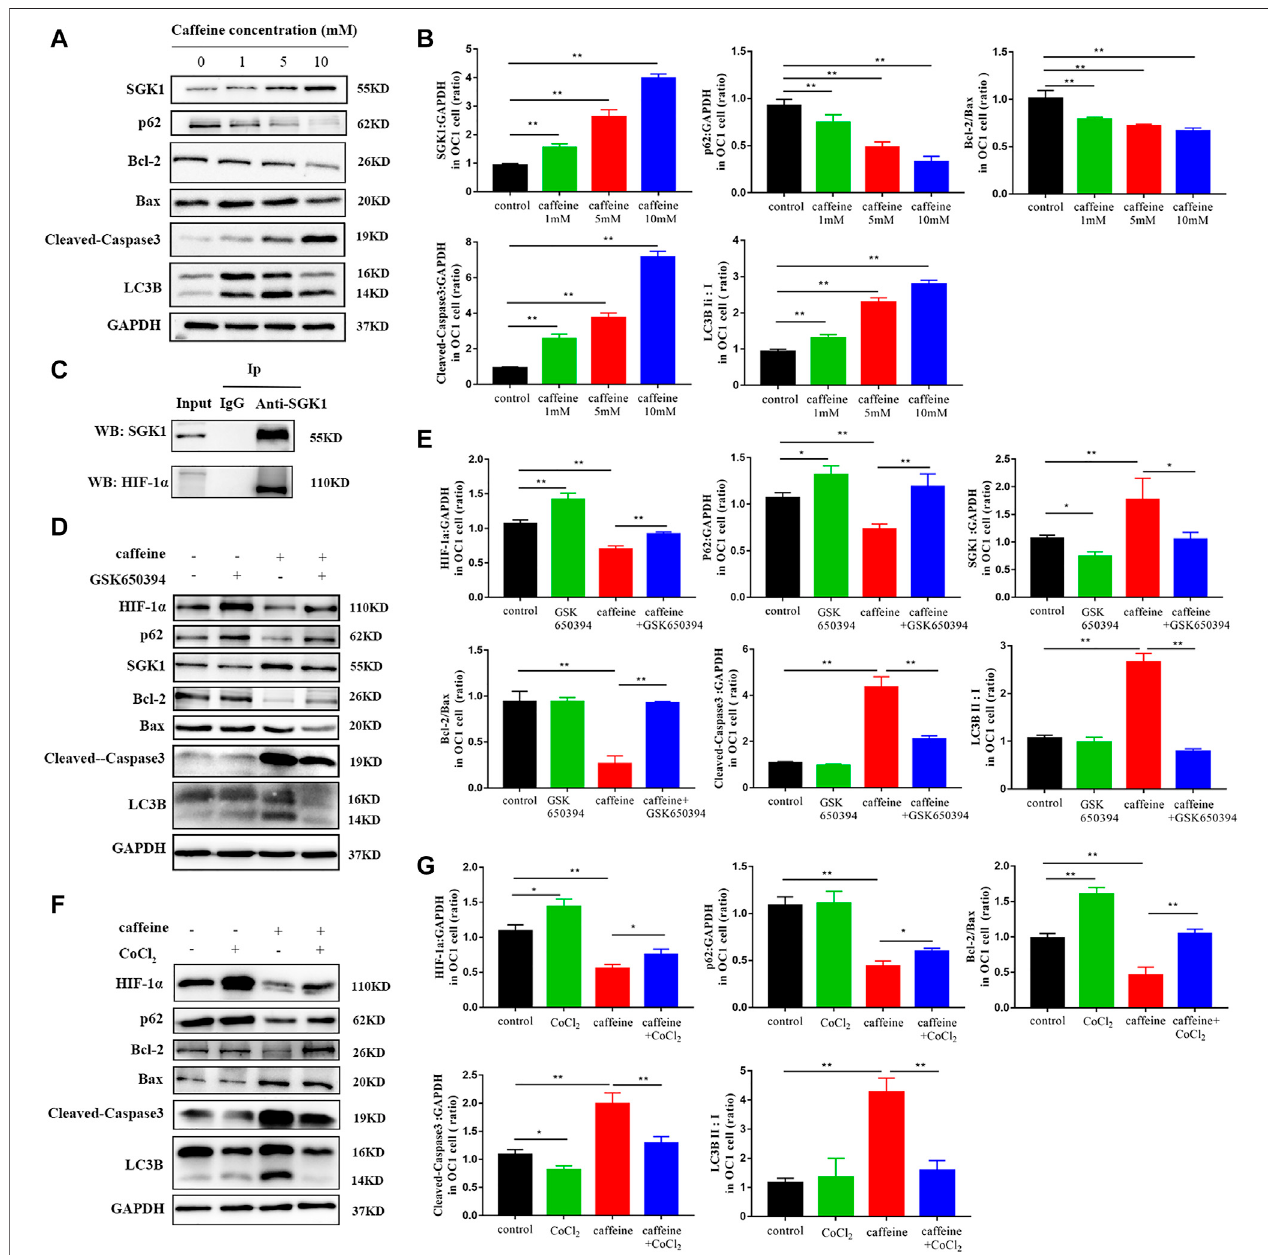
FIGURE5| Caffeineinducedautophagyandapoptosis via theSGK1/HIF-1 α signalingpathway. (A) WesternblottingshowedchangesofSGK1,p62,LC3B,Bcl-2, Bax, and Cleaved-Caspase3 in HEI-OC1 cell lines after a 24-h caffeine treatment with different concentrations, and GAPDH was used as the internal control. (B) Quanti fi cationoftheWestern blotinSGK1,p62, LC3B,Bcl-2,Bax,andCleaved-Caspase3. Experiments wererepeatedthreetimes,anddataareshownasthemean ± SD, **p < 0.01 . (C) Co-immunoprecipitation (Co-IP) analysis of SGK1 and HIF-1 α protein interaction. (D) Western blot assay was employed to investigate the expressionsofHIF-1 α ,SGK1,P62,LC3B,andCleaved-Caspase3inHEI-OC1cellsafter24 htreatment withorwithoutcaffeineandGSK650394.GAPDHwasusedas the internal control. (E) Quanti fi cation of the Western blot in HIF-1 α , SGK1, P62, LC3B, Bcl-2, Bax, and Cleaved-Caspase3. Experiments were repeated three times. Dataareshownasmeans ± SD, **p < 0.01,*p < 0.05 . (F) WesternblotassaywasemployedtoinvestigatetheexpressionofHIF-1 α ,P62,LC3B,andCleaved-Caspase3 in HEI-OC1 cells after a 24-h treatment with or without caffeine and CoCl 2 . GAPDH was used as the internal control. (G) Quanti fi cation of the Western blot in (F) . Experiments were repeated three times. Data are shown as means ± SD, **p < 0.01, *p < 0.05 .